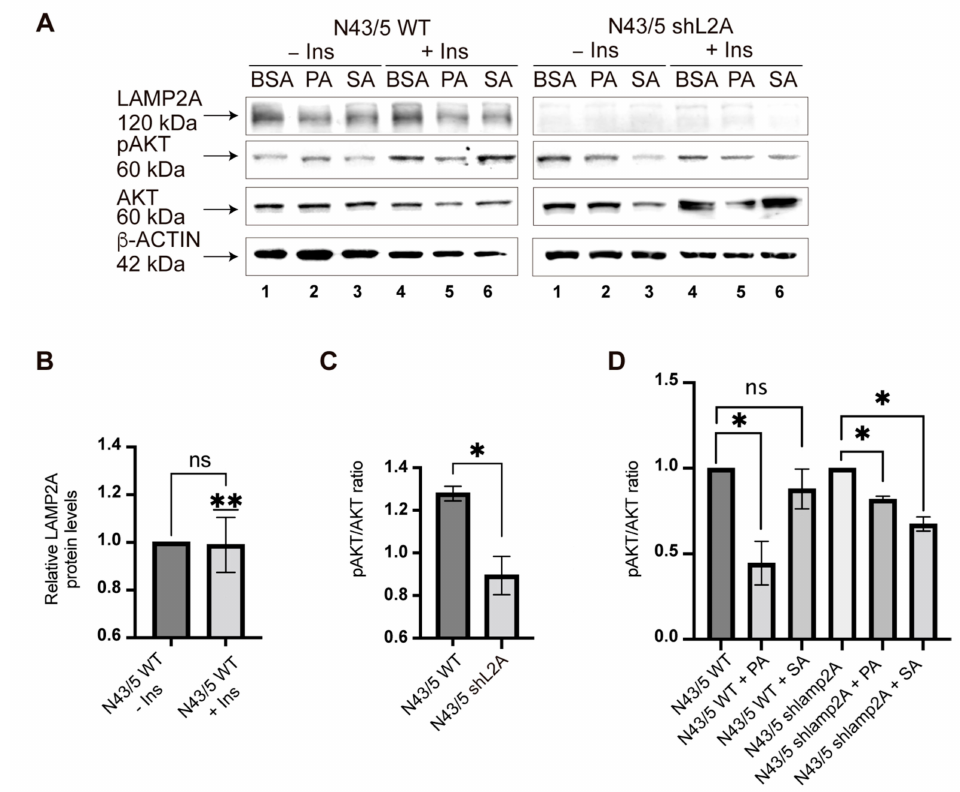
Figure 7. PA and SA can affect the insulin signaling response in POMC-like neurons by inhibiting CMA. ( A ) N43/5 wild-type and N43/5 shL2A C2 cell lines were treated with BSA or 100 µ M of PA or SA for 6 h and then stimulated with insulin. The insulin response was evaluated by Western blot using pAKT antibody. Total AKT and β -ACTIN antibodies were used as a control. ( B ) The graph compares the basal (BSA) LAMP2A protein levels in N43/5 WT with or without insulin stimulation (lines 1 and 4). The quantification was analyzed using an unpaired t test and a one sample t test ( n = 3). ( C ) The graph compares the basal (BSA) pAKT/AKT ratios between WT and N43/5 shL2A cells with or without insulin stimulation (lines 1 and 4). The quantification was analyzed using an unpaired t test ( n = 3). ( D ) The basal (BSA) pAKT/AKT ratios (Figure 7B) were considered as 1 and compared with the pAKT/AKT ratios of the cells pretreated with PA and SA (ratio lines 1 and 4 versus, ratio lines 2 and 5, or lines 3 and 6). The quantification was analyzed using an unpaired t test ( n = 3). Note: before calculating the pAKT/AKT ratios, every pAKT and AKT signal was normalized against its respective β -ACTIN signal. n.s. = non-significant, * = p < 0.05, ** = p <